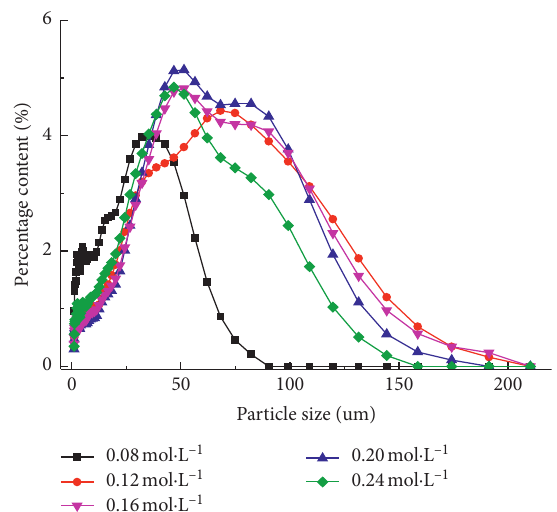
Figure 10: Grading of ore particles smaller than 0.1 mm.